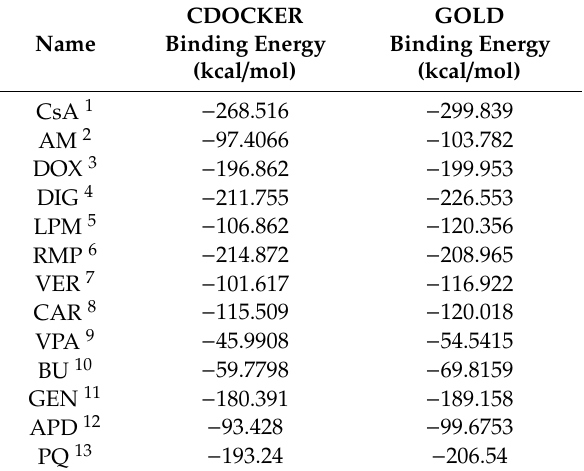
Table 13. Estimate of the overall binding free energies of some well-known substrates and inhibitors of P-gp using the homology model.